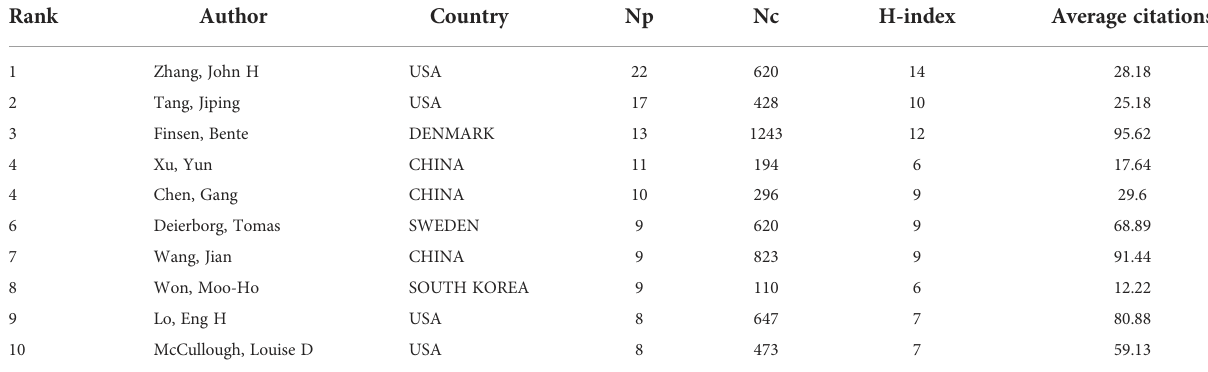
TABLE 3 Top 10 most productive authors.